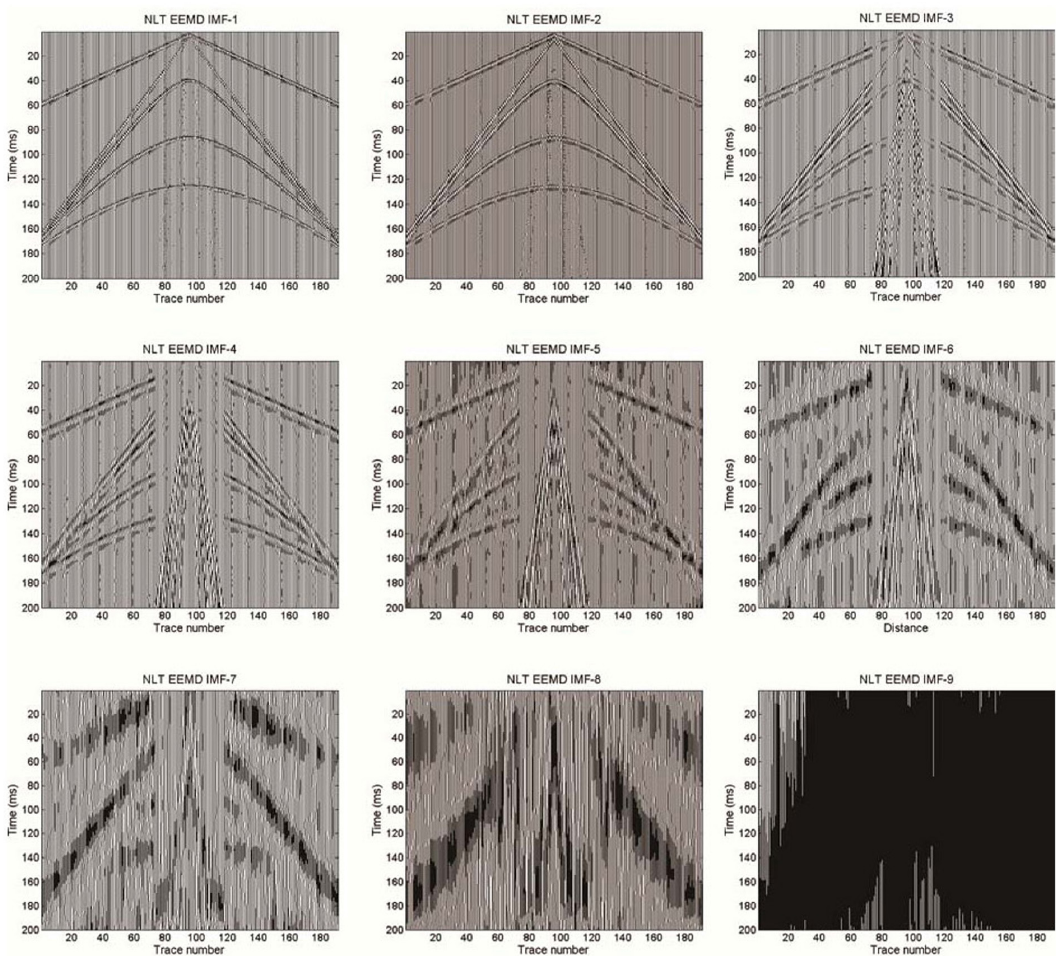
Fig. 4. Filter bank of the harmonic noise affected model data with logarithmic